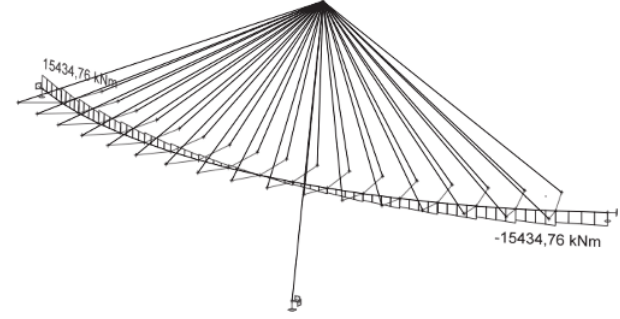
Figure 29 Deformed configuration: bilateral case